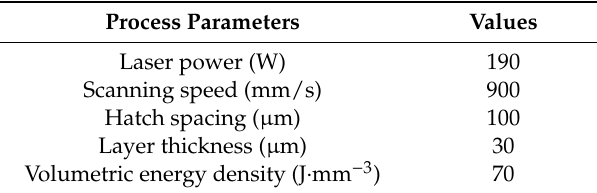
Table 2. The process parameters used for manufacturing hollow truss structures.